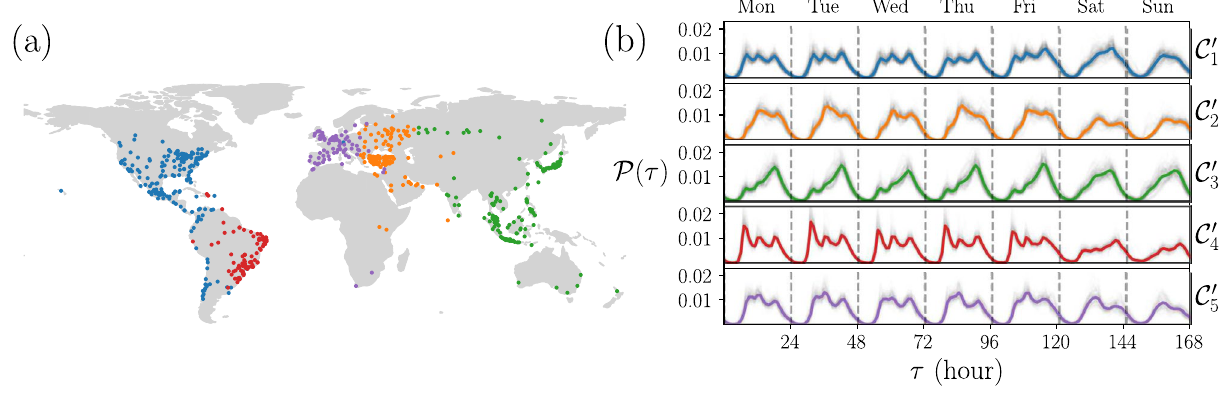
Figure 7. Pattern identification using agglomerative hierarchical clustering. ( a ) Geographical representation of 5 clusters detected. ( b ) Activity patterns in each group. All figures were created using python 3.8 and the matplotlib (3.5.0) package (https:// matpl otlib. org). The map in panel ( a ) was created using the geopandas (0.12.1) package (https:// geopa ndas.